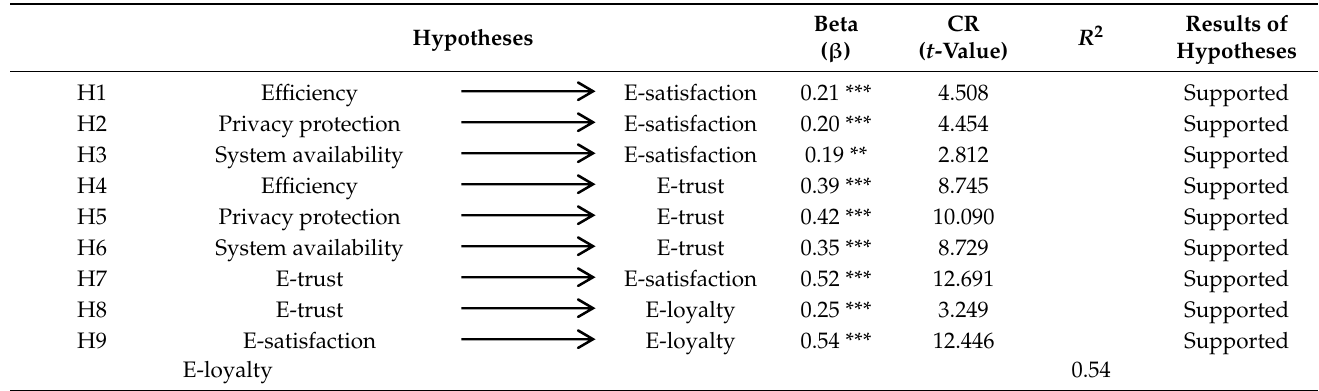
Figure 2. structural and measurement model ( ** p < 0.01; *** p < 0.001) . Table 3. The results of the structural proposed model.